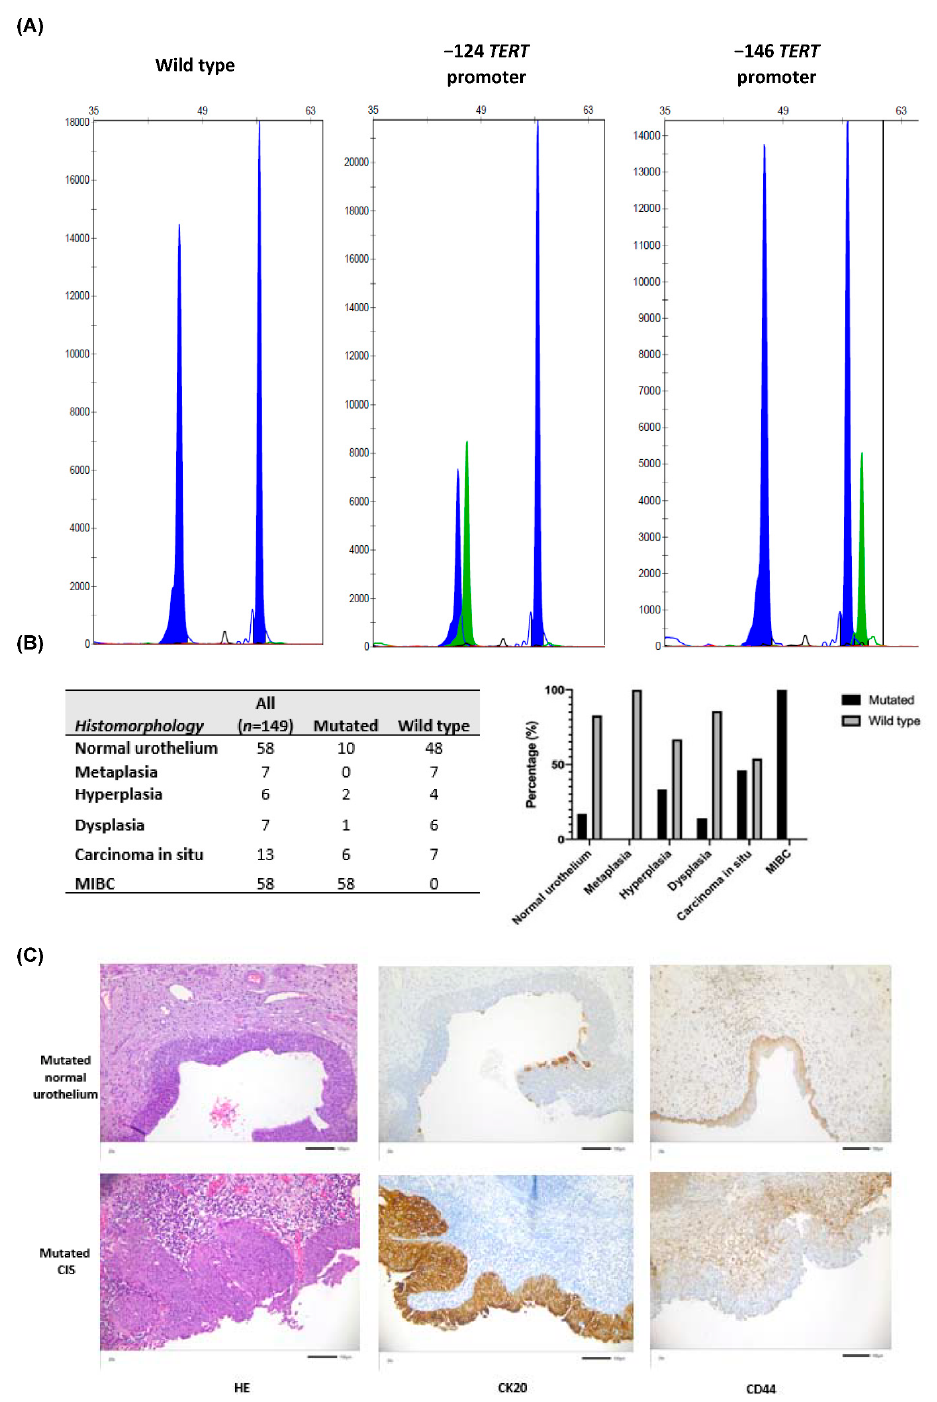
Figure 1. ( A ) Representative SNaPshot analysis of the TERT promoter hot spot mutations. The X-axis represents base pair length of the DNA fragment and the Y-axis represents the intensity of fluorescence signal of the labeled nucleotide. The Blue peak for each promoter mutations corresponds to a Guanine and the green peak an Adenine. ( B ) Total numbers as well as percentages of TERT mutated and wild type sequences analyzed within each tissue group are shown. ( C ) Representative Hematoxylin and Eosin, CK20 and CD44 stained images of TERT promoter mutated tumor associated normal urothelium and TERT promoter mutated CIS (all magnification: 200 × ). TERT mutated tumor associated urothelium demonstrated the physiological expression of CK20 staining within the umbrella cells and CD44 expression in the basal and over lying tissue layers. In contrast, in TERT mutated CIS, CK20 was abnormally expressed not only in the umbrella cells but also in adjacent tissue layers, and expression of CD44 was restricted to the basal